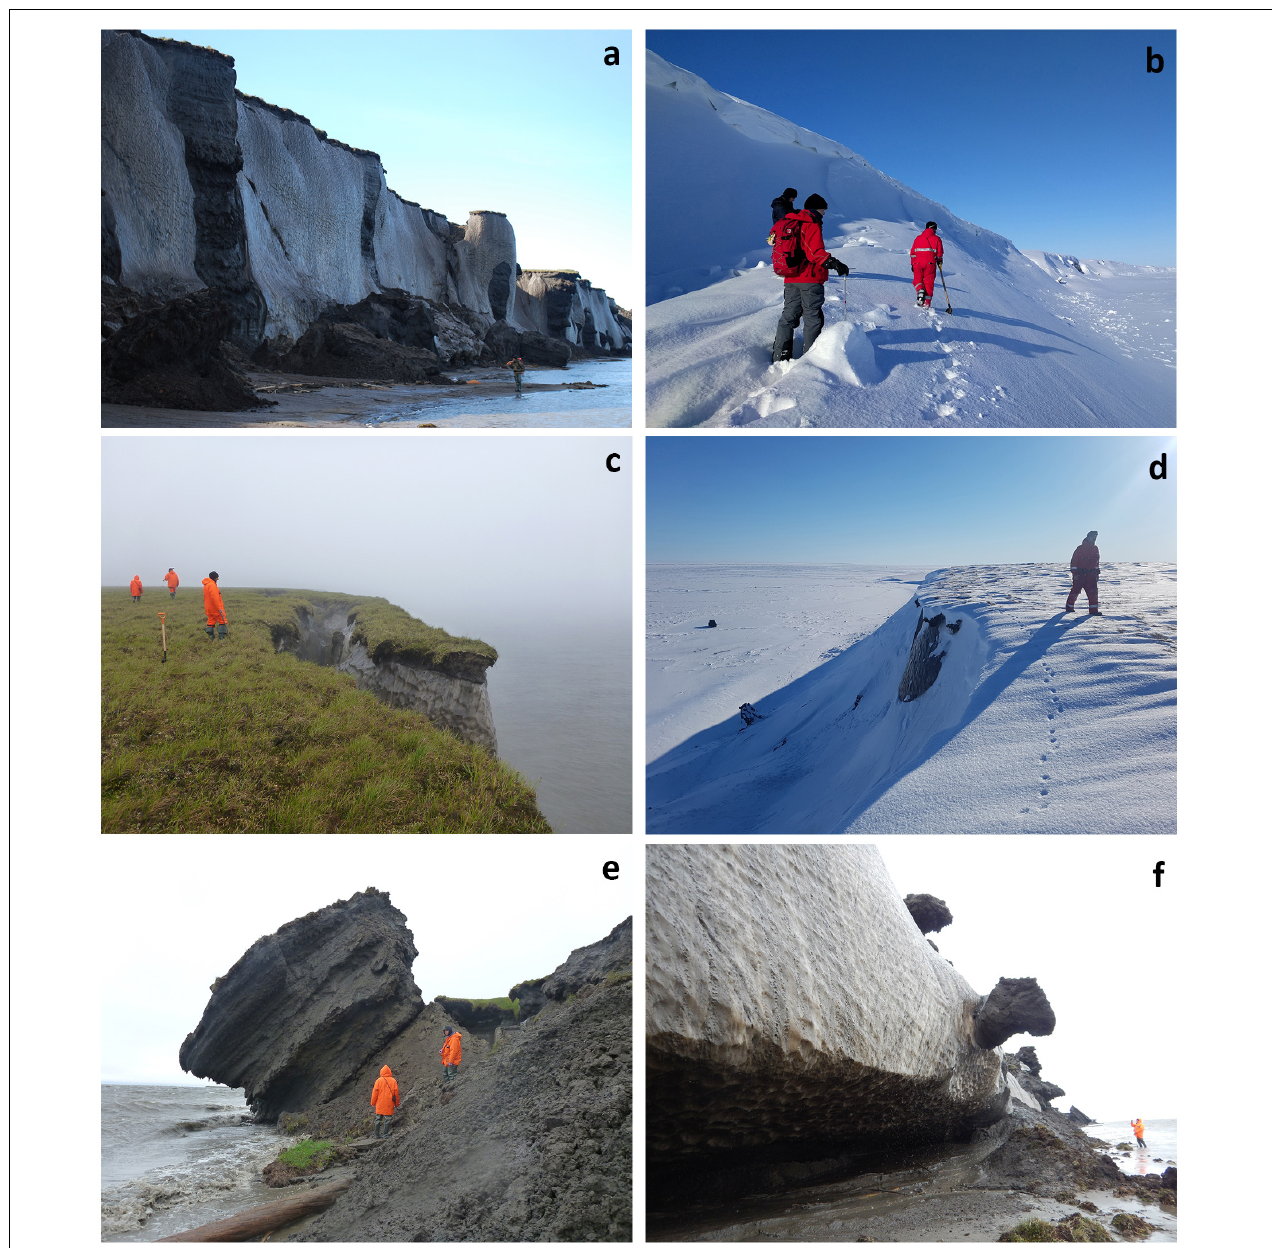
FIGURE 3 | (a) Sobo-Sise Cliff in August 2014 with person for scale (photo: T. Opel, 11 August 2014), (b) Sobo-Sise Cliff in April 2019 with snow drifts (photo: J. Strauss, 5 April 2019), (c) cliff-top with a large crack (photo: G. Grosse, 12 August 2014), (d) cliff-top with thin snow cover (photo: J. Palmtag, 5 April 2019), (e) collapsing sediment block at the Sobo-Sise Cliff (photo: G. Grosse, 12 August 2014), (f) thermo-erosional niche and peat blocks at the base of the cliff (photo: M. Fuchs, 12 August 2014).